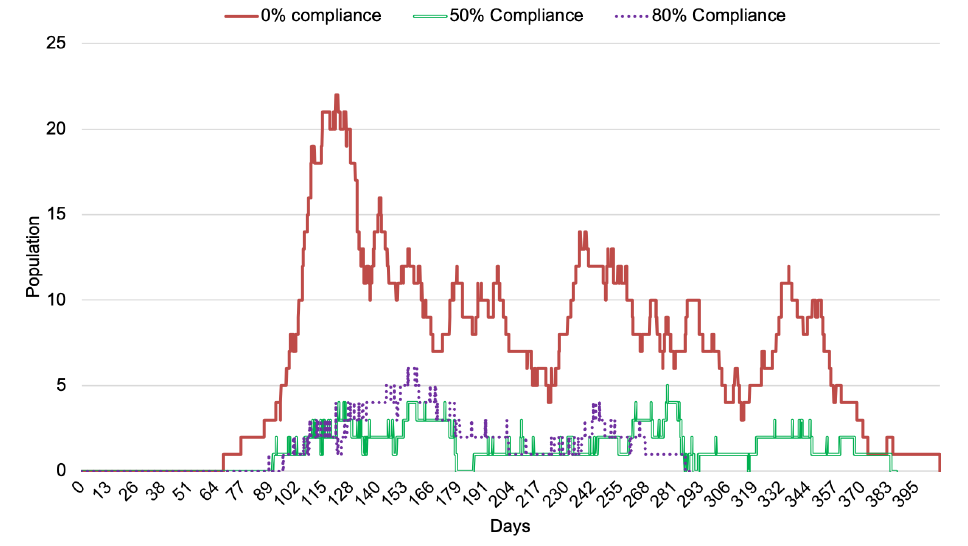
Figure 5. Compliance rate of population versus infectious cases through contaminated surfaces ( s = 1.8 m/s, N OE =